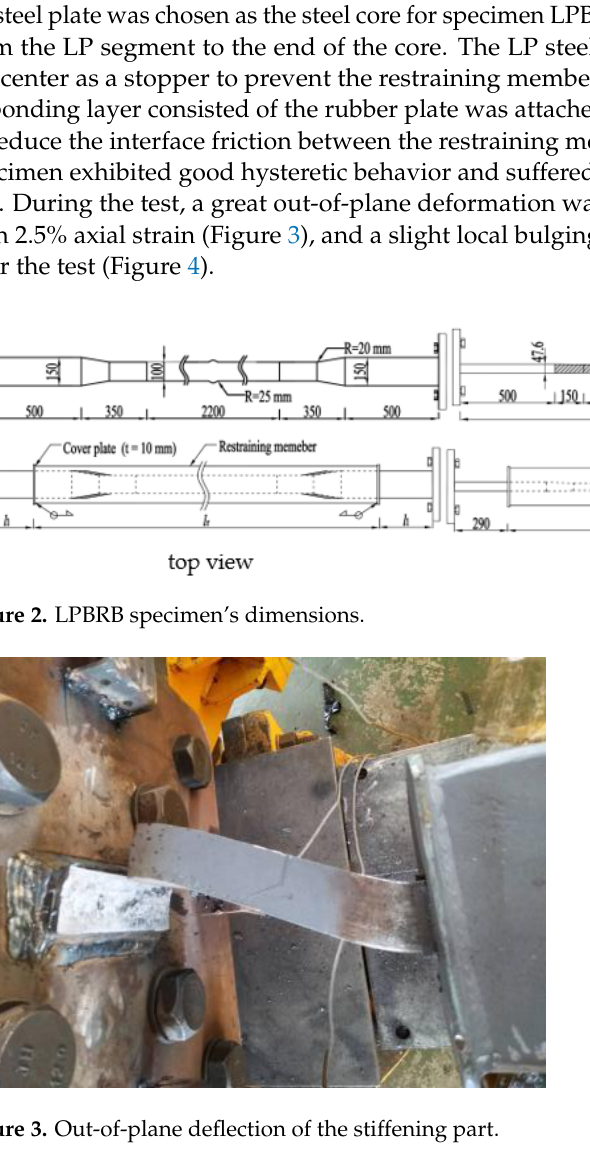
Figure 3. Out-of-plane deflection of the stiffening